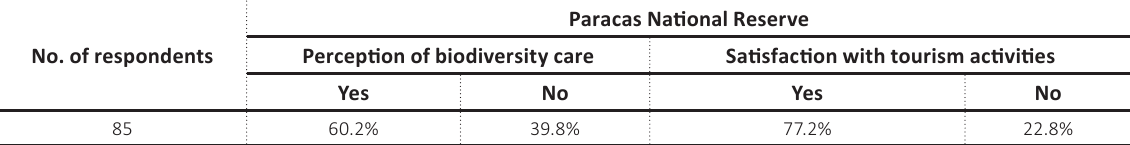
Table 1. Satisfaction with the Paracas National Reserve No. of respondents